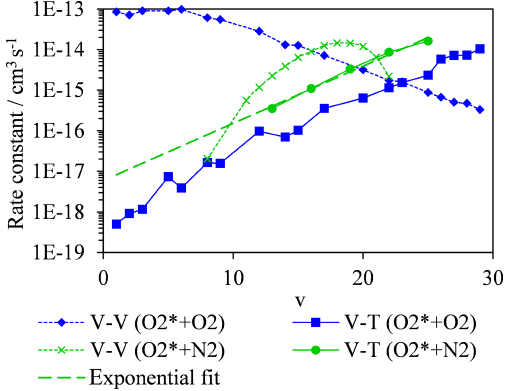
Figure 5. Calculated quenching rates of O 2 (X 3 (cid:54) − g , v> 0) for V – T energy transfer to bath gas O 2 (blue squares) or N 2 (green circles), with variation in the vibrational quantum state. Also shown are the corresponding variations in V – V quenching rates of O 2 (X 3 (cid:54) − g , v> 0) in a bath gas of O 2 (blue diamonds) and N 2 (green crosses). Data are taken from Billing (1994), Coletti and Billing (2002) and Park and Slanger